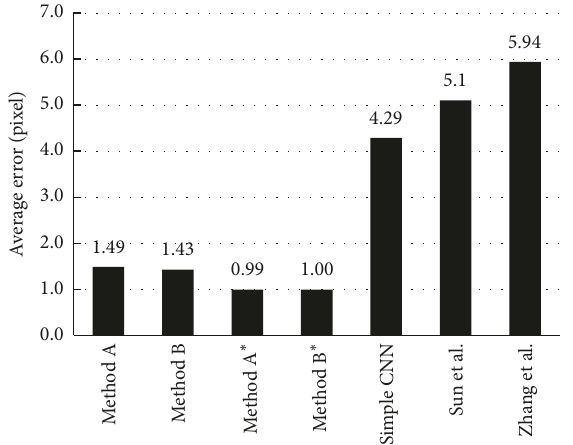
Figure 7: Average error of each CNN